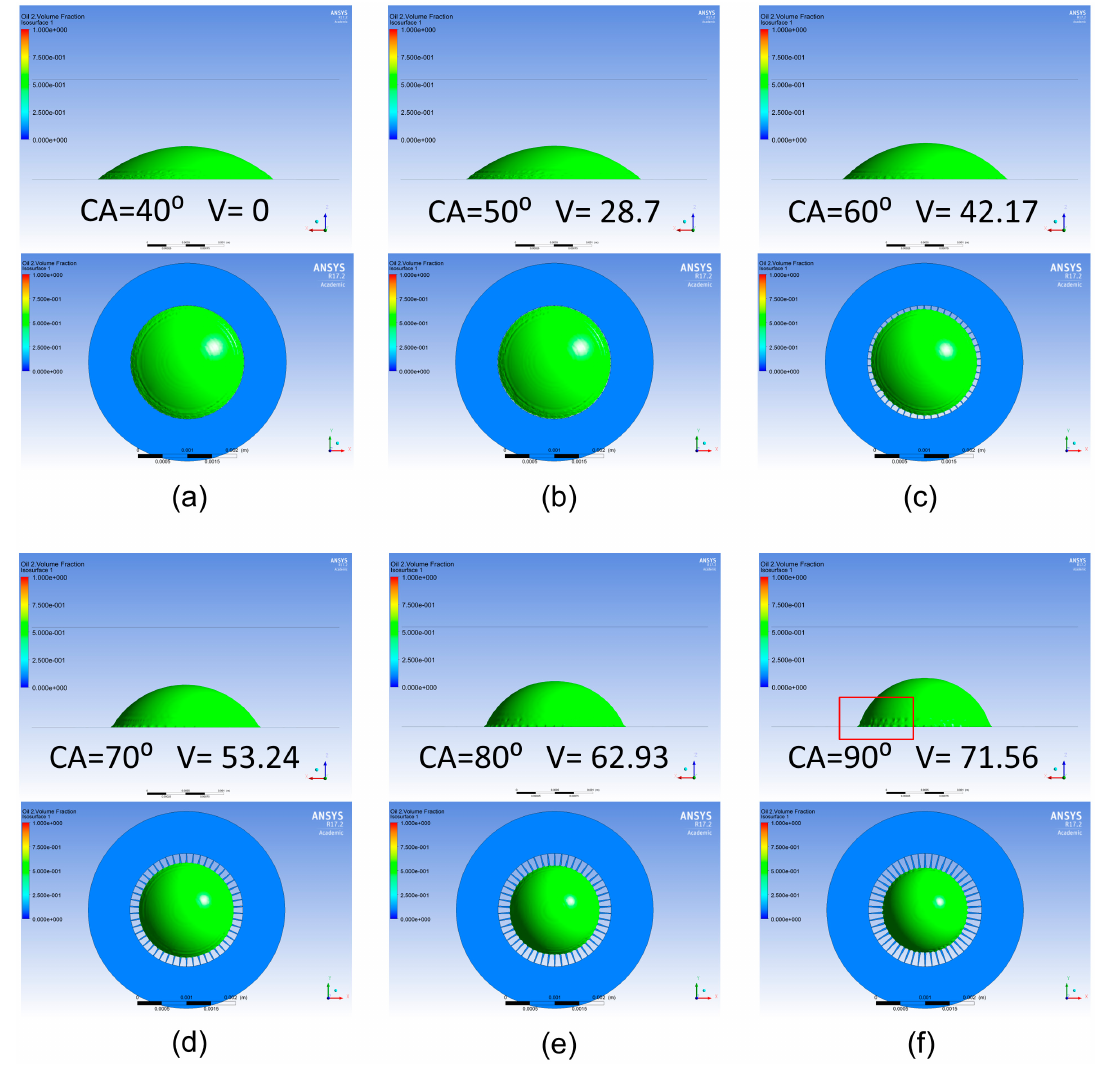
Figure 5. Computational results of ANSYS Fluent simulation of silicone oil droplet surrounded by water under different levels of electrowetting actuation. The underlying electrode structure is shown in blue, the surface of the interface between water and oil is shown in green. Scalloping effect at interface is highlighted by red square. ( a ) The initial state of the fluidics system showing both top and profile view. The 40° contact angle of the oil is equivalent to no externally applied voltage; ( b ) The contact angle changes to 50° at 28.7 V after 100 ms elapsed simulation time; ( c ) the contact angle changes to 60° at 42.17 V after 100 ms; ( d ) the contact angle changes to 70° at 53.24 V after 100 ms; ( e ) the contact angle changes to 80° at 62.93 V after 100 ms; ( f ) the contact angle changes to 90° at 71.56 V after 100 ms.